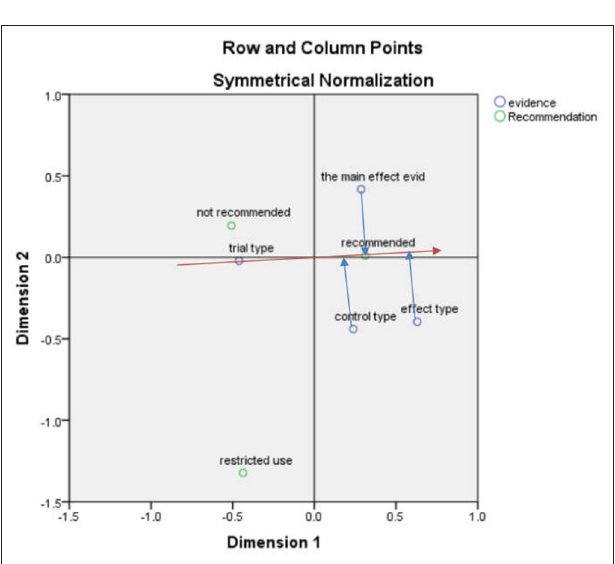
FIGURE 3 | Correspondence analysis biplot (recommendation and clinical